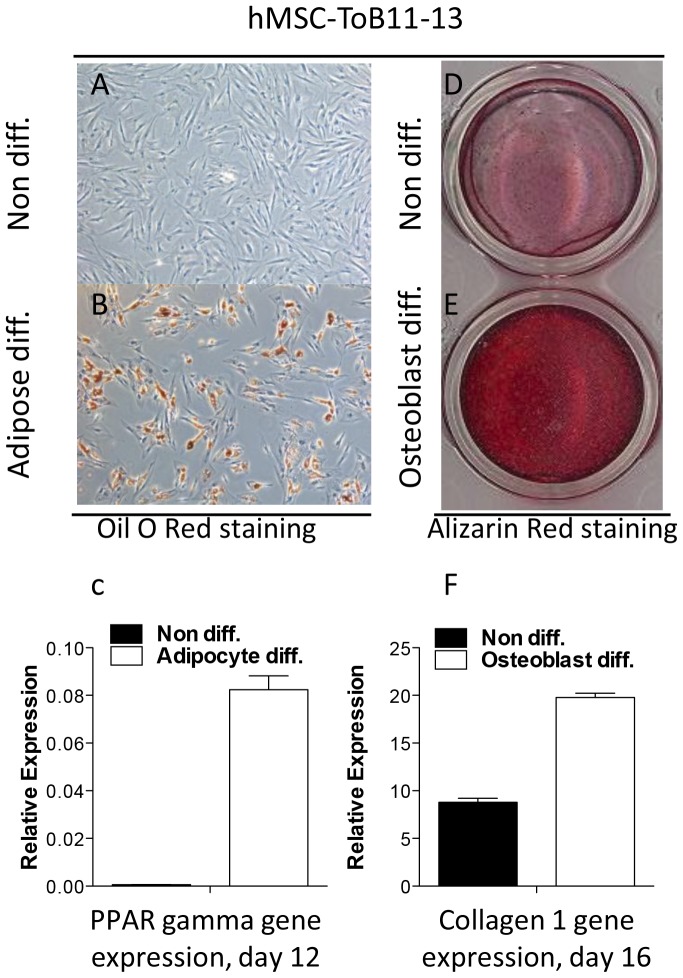
Differentiation of hMSC to adipocytes and osteoblasts.Representative images for Oil O Red and Alizarin red staining demonstrating adipocyte and osteoblasts differentiation of hMSC cell lines cultured under adipogenic and osteogenic conditions, respectively. Non-differentiated cells were not stained (A and D), while the adipocyte differentiated cells were stained with Oil O red (B) and Alizarin red stained the matrix formed by osteoblasts (E). qPCR data shows marked up-regulation of PPAR gamma gene expression after adipocyte differentiation (C) and up-regulation of Collagen 1 gene expression in osteoblast differentiated cells (F).